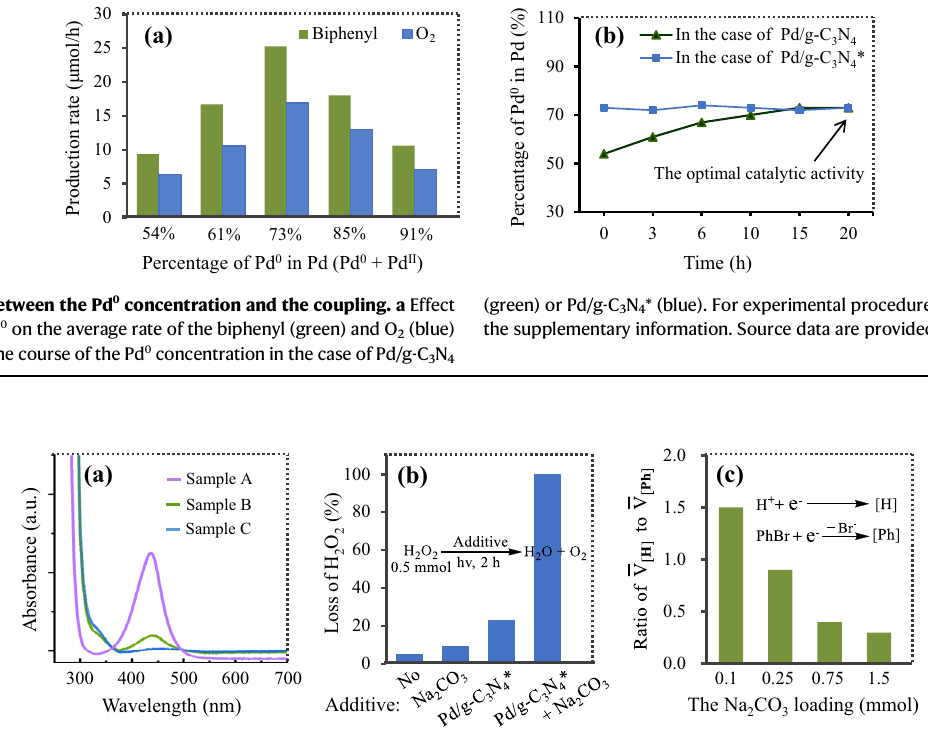
Fig. 9 | Investigation onthe role ofNa 2 CO 3 . a UV-Vis spectroscopy related to the produced H 2 O 2 in the coupling of bromobenzene. Sample A (purple curve): 0.4mmol/Laqueous solution of H 2 O 2 , Sample B (green curve):the produced H 2 O 2 under standard conditions (no Na 2 CO 3 ) in Fig. 5, Sample C (blue curve): the pro- duced H 2 O 2 under standard conditions in Fig. 5, a.u.: arbitrary units. b The H 2 O 2